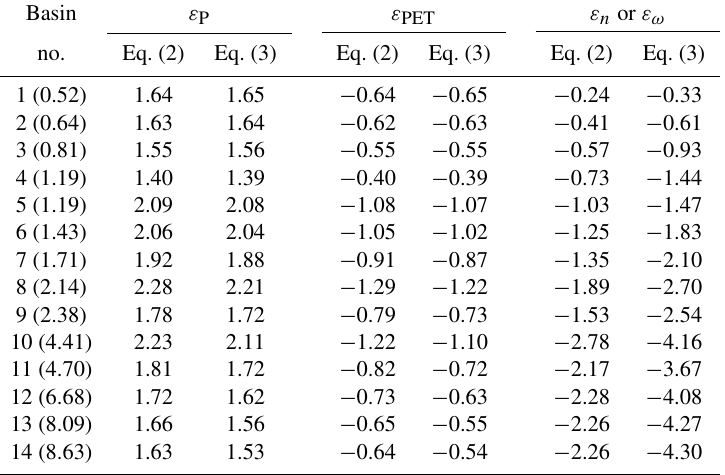
Table 2. The estimations of P elasticity, PET elasticity, and catchment properties’ elasticity of R in the 14 river basins of China based on Eqs. (2) and (3). The basin number is consistent with that given in Fig. 1. The numbers in the parentheses indicate the 1960–2008 mean aridity